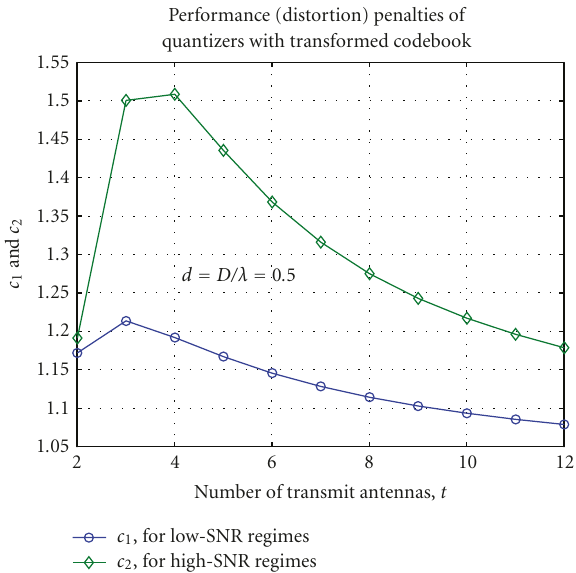
Figure 4: Demonstration of the distortion penalties of a MISO system using transformed codebooks over correlated fading chan- nels with di ff erent number of transmit antennas of antenna spacing d = D/λ = 0 .